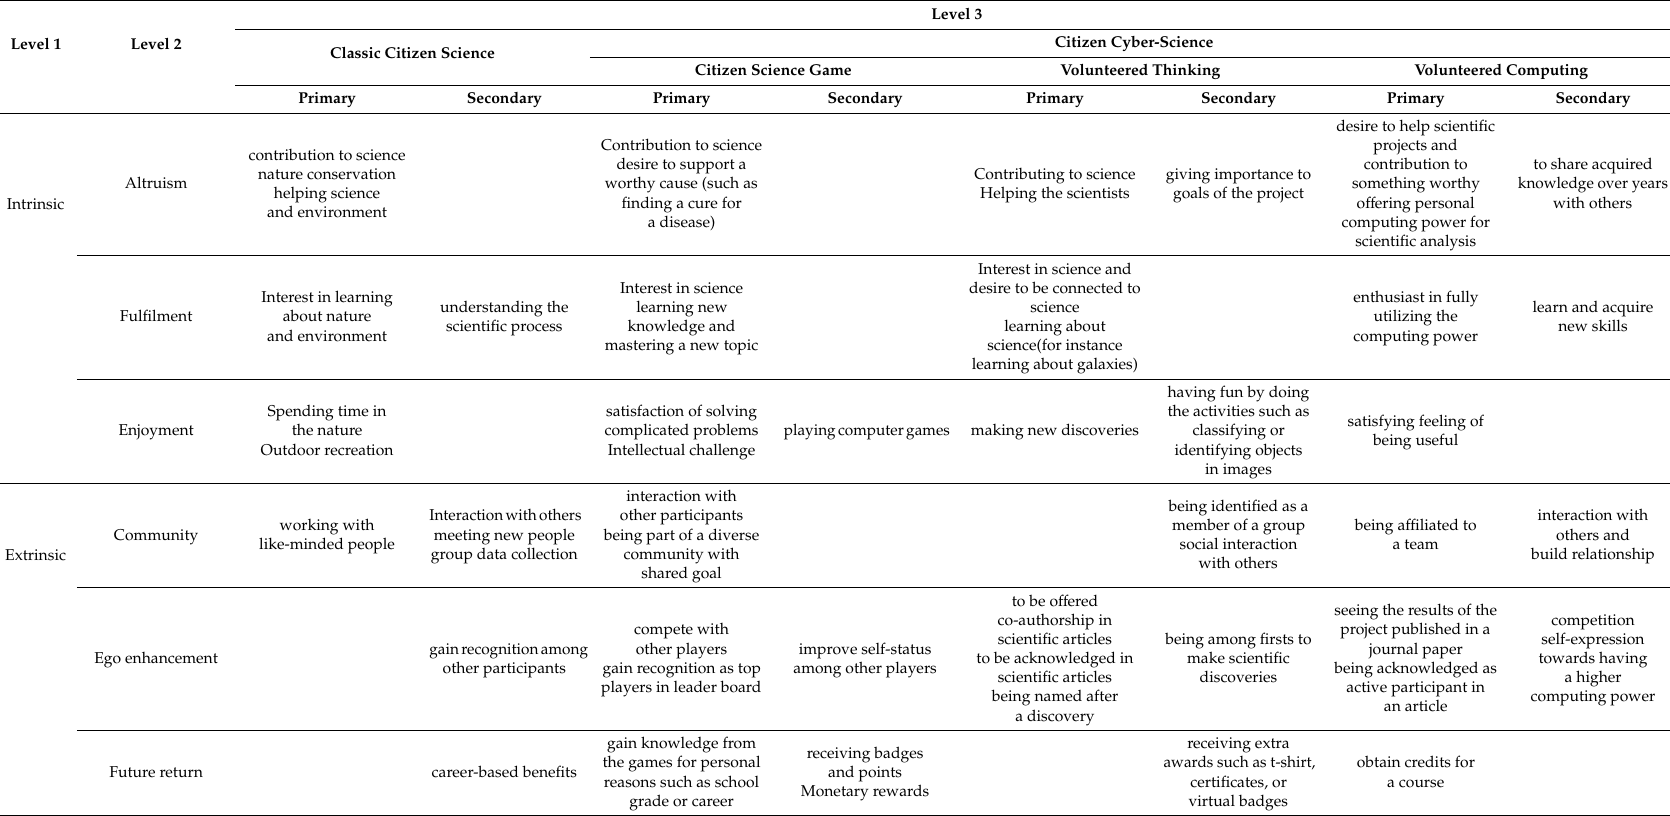
Table 3. A framework to classify volunteers’ motivation in citizen science